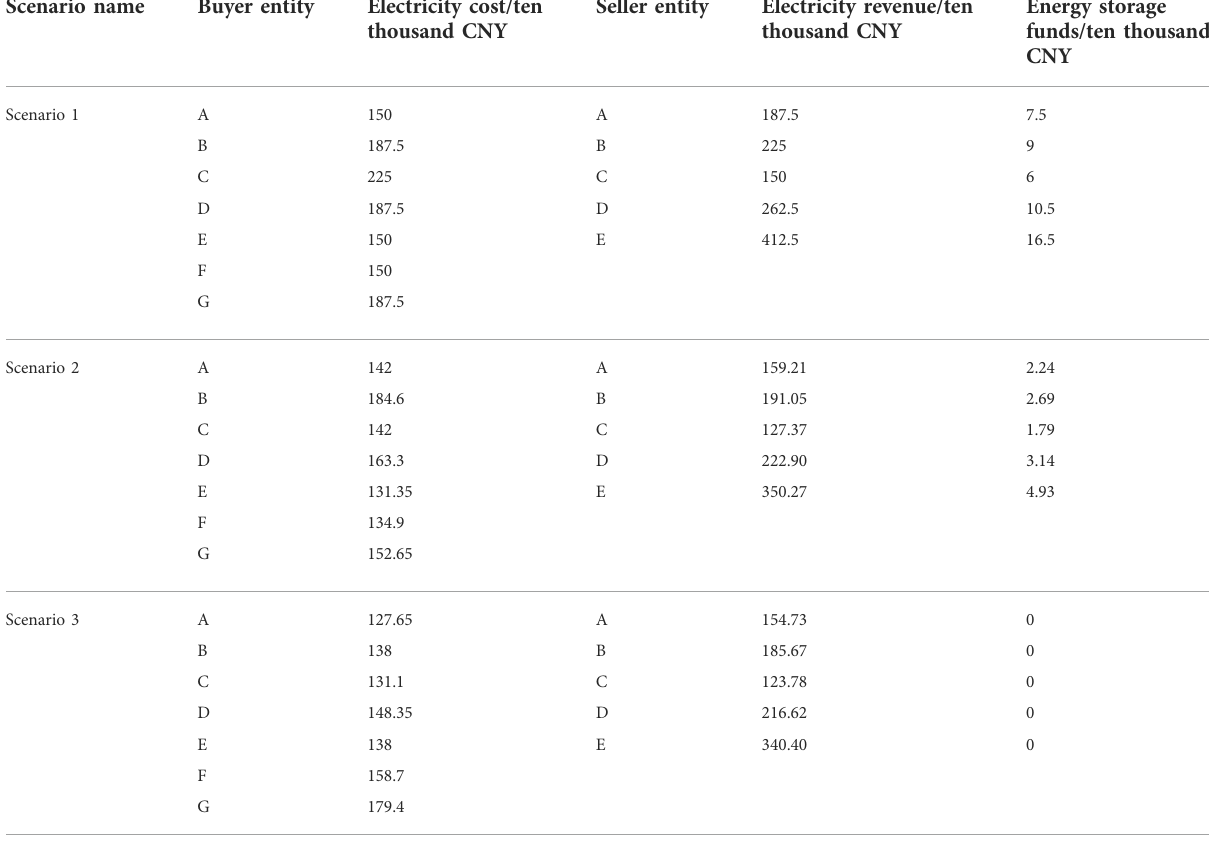
TABLE 5 Settlement of the differentiated green electricity trading market of three scenarios.